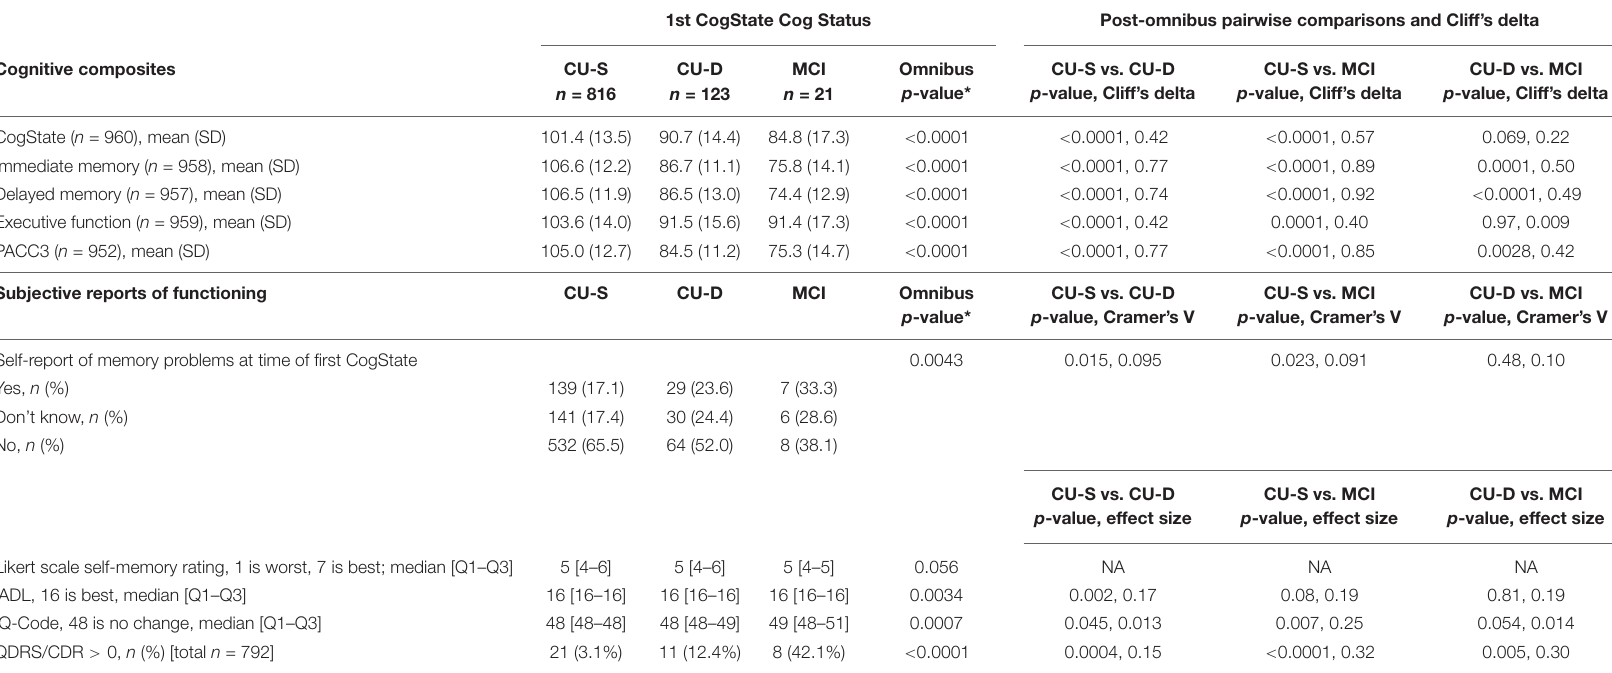
TABLE 3 | Concurrent validity evidence (subset with